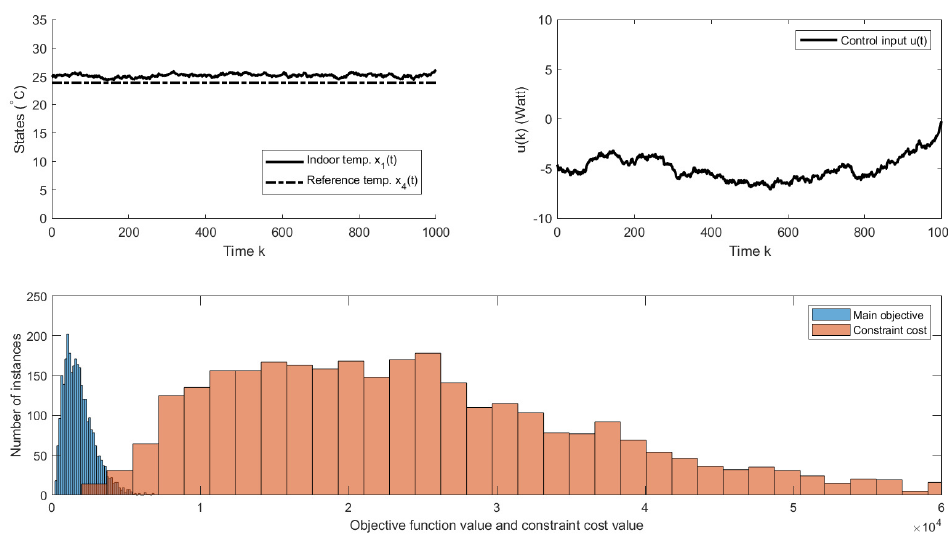
Figure 2. With γ = 25,000, the top figures show evolution of the indoor temperature x 1 ( t ) , reference temperature x 4 ( t ) , and the input u ( t ) . The bottom figure depicts the histograms of the objective function and constraint